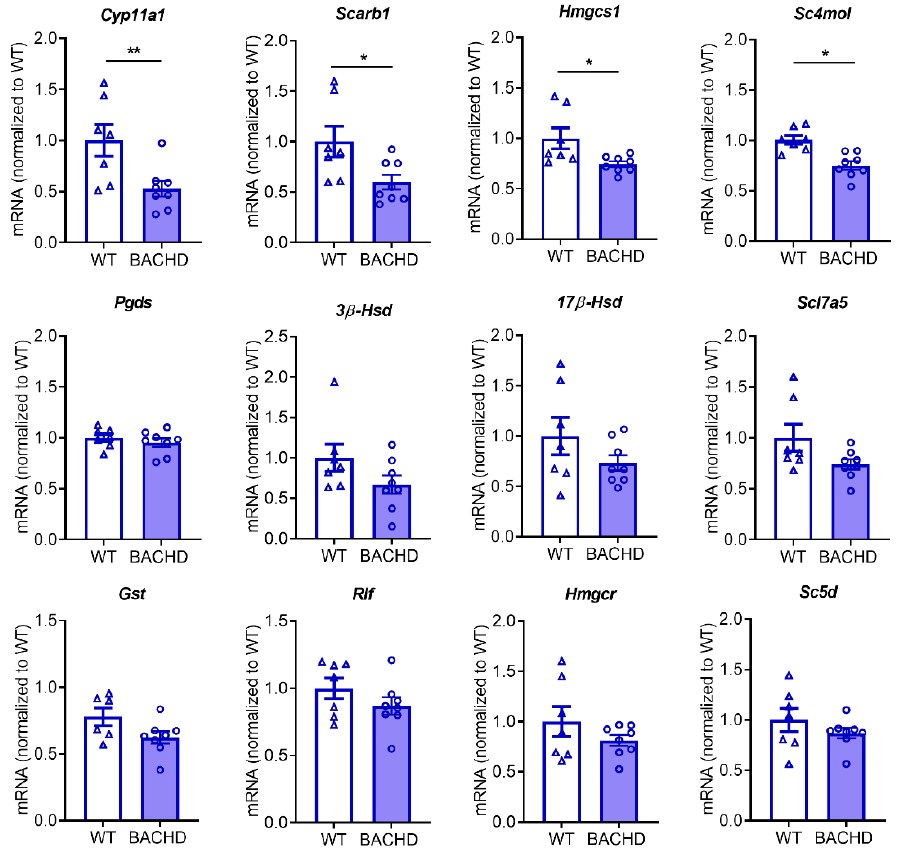
Figure A1. Normal neuronal morphology and no brain caspase activation in BACHD rats at 9 months of age ( n = 4–5/genotype/sex). ( A ) Neuronal nuclei are visualized by NeuN staining showing comparable brain structure and cell density in BACHD and WT rats. ( B ) Representative image of western blot analysis on caspase activation ( n = 3/genotype/sex). A commercial sample of cell ex- tracts treated with cytochrome c was used as positive control. In BACHD or WT rats no specific band indicating cleaved (activated) caspase 3 was detected.